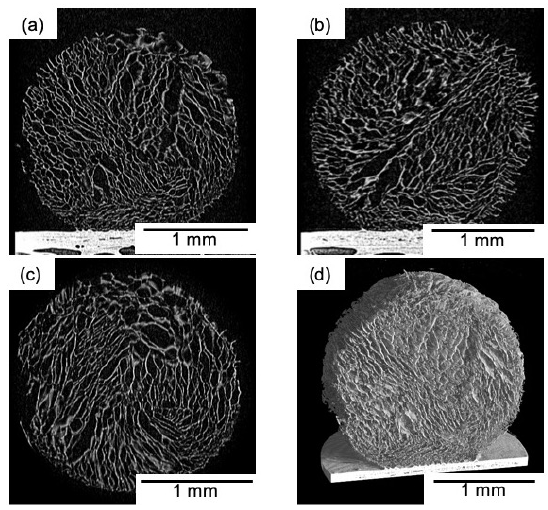
Figure 3. Transverse plane, ( a ) frontal slice (x,z), ( b ) sagittal slice (y,z), ( c ) axial slice (x,y) and 3D reconstruction ( d ) images of chitosan-siloxane hybrid spheres (ChG05, − 20 ◦ C) obtained using micro-CT scan. Table 2. Pore sizes of the chitosan-siloxane spheres.